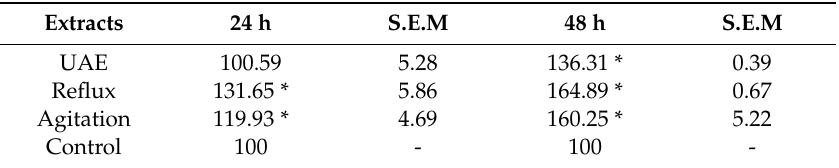
Table 4. E ff ects of C. papaya extract treatment from various extraction techniques on collagen synthesis in HSF1184 cells after 24 and 48 h at a concentration of 12.5 µ g /